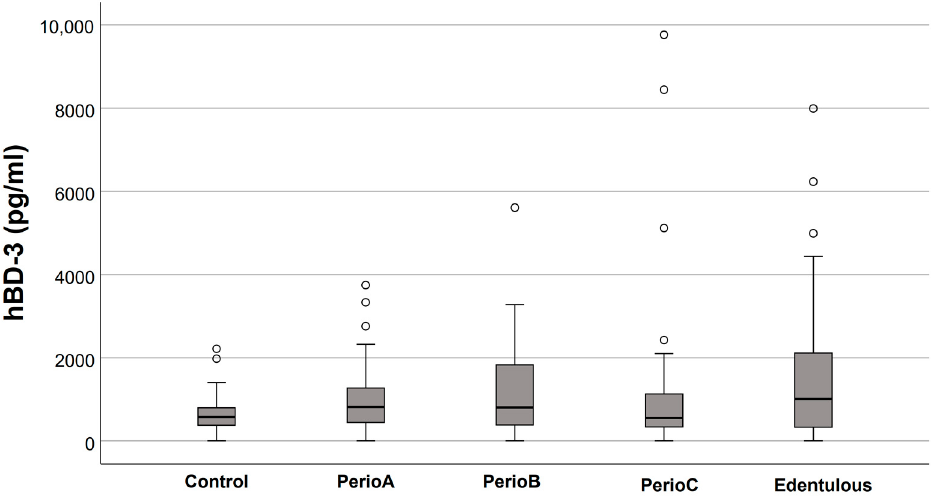
Figure 3. Salivary human β -defensin (hBD)-2 levels in relation to the extent of periodontal destruction (empty circles indicate outliers). No significant differences were found between the groups.